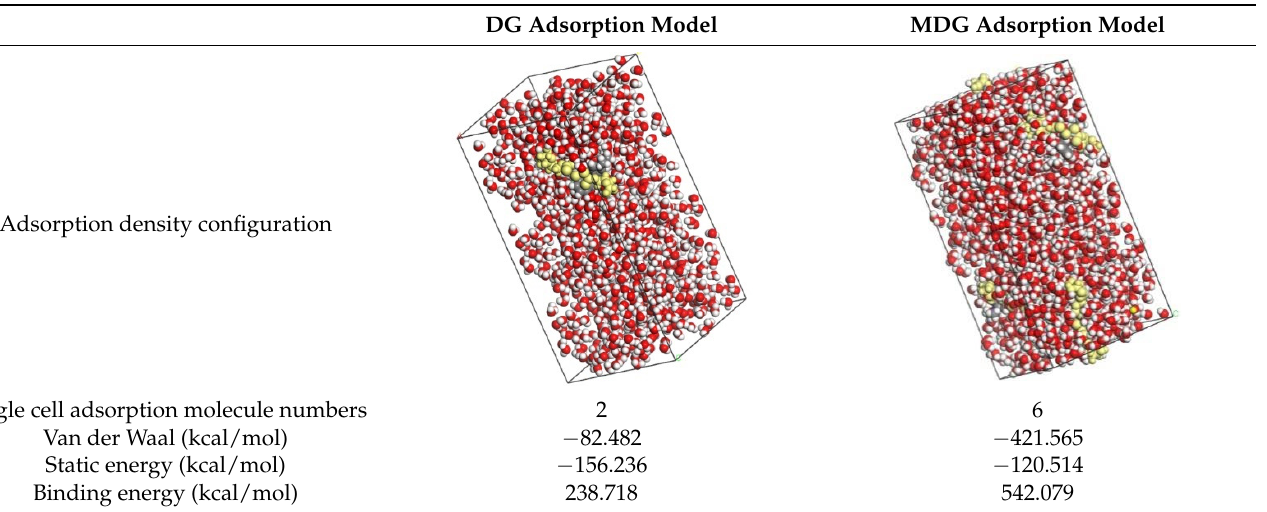
Table 6. DG and MDG AC simulated adsorption interaction.